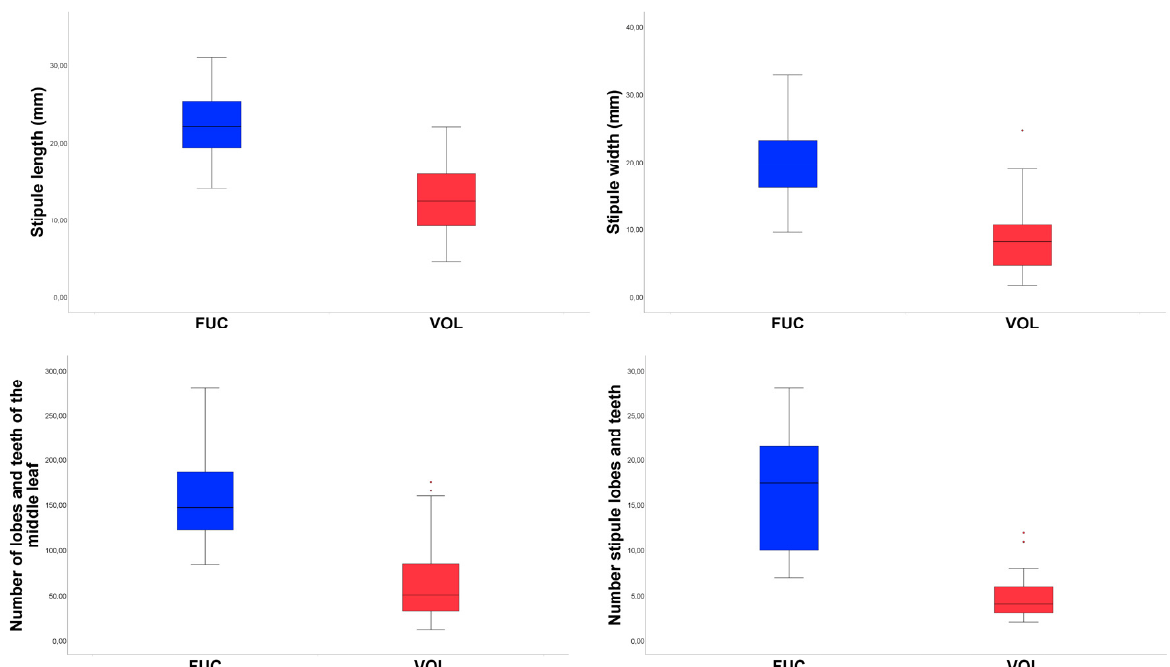
Figure 4. Boxplots expressing morphological variation between A. fucensis (FUC) and A. volgensis (VOL). Outlined central box depicts middle 50% of data, extending from 25th and 75th percentiles, and horizontal bar is the median. Ends of vertical lines (or “whiskers”) indicate minimum and maximum data values, unless outliers are present, in which case whiskers extend to a maximum of 1.5 times inter-quartile range. Circles indicate outliers.